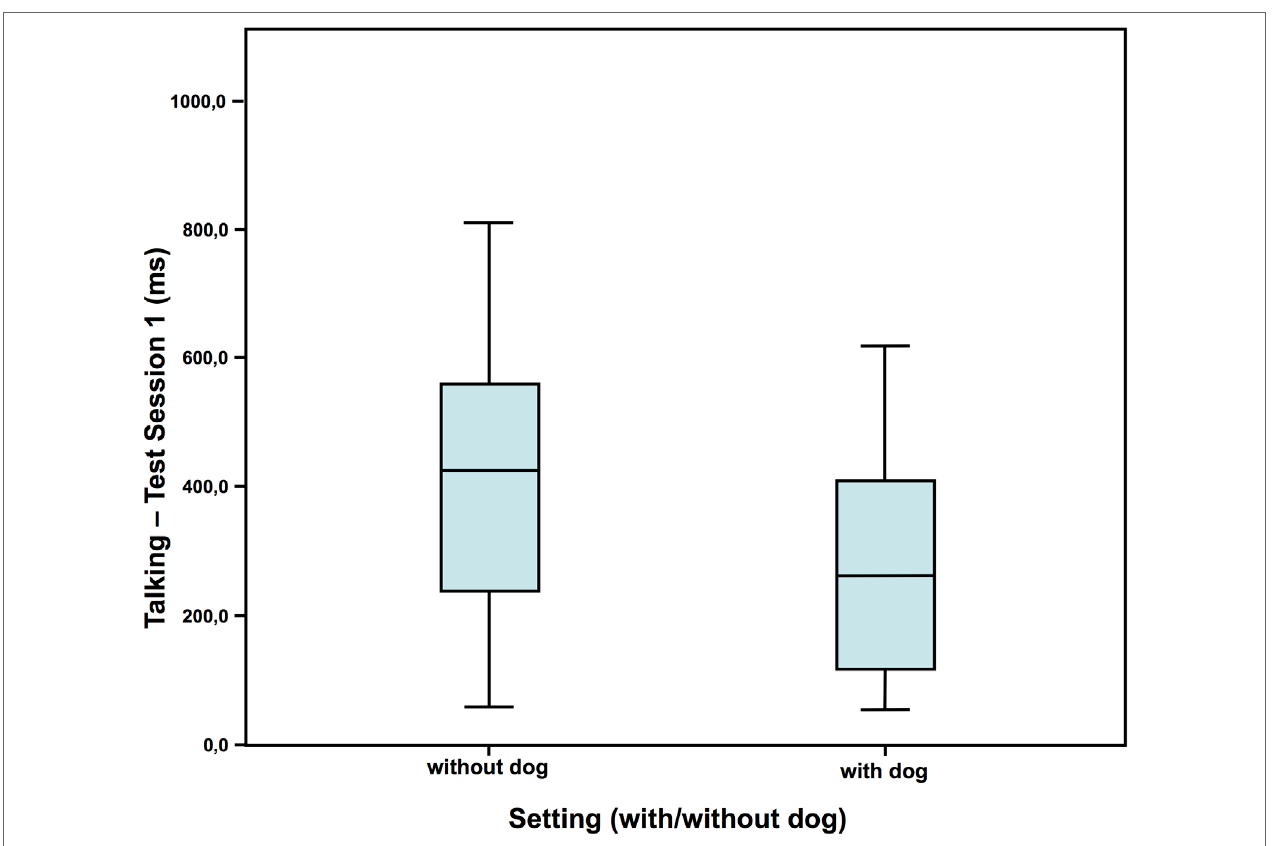
FigUre 2 | Duration of talking in test session 1—comparison of the two settings